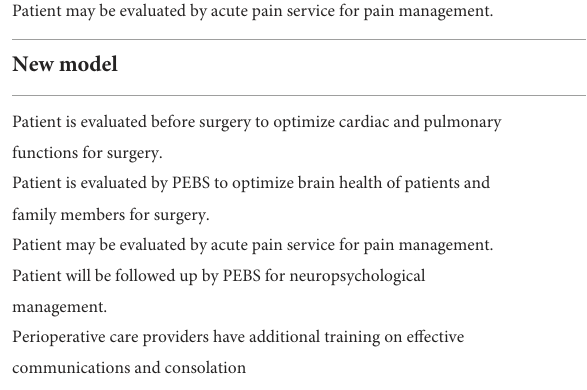
TABLE 1 Proposed changes in evaluating and preparing patients for